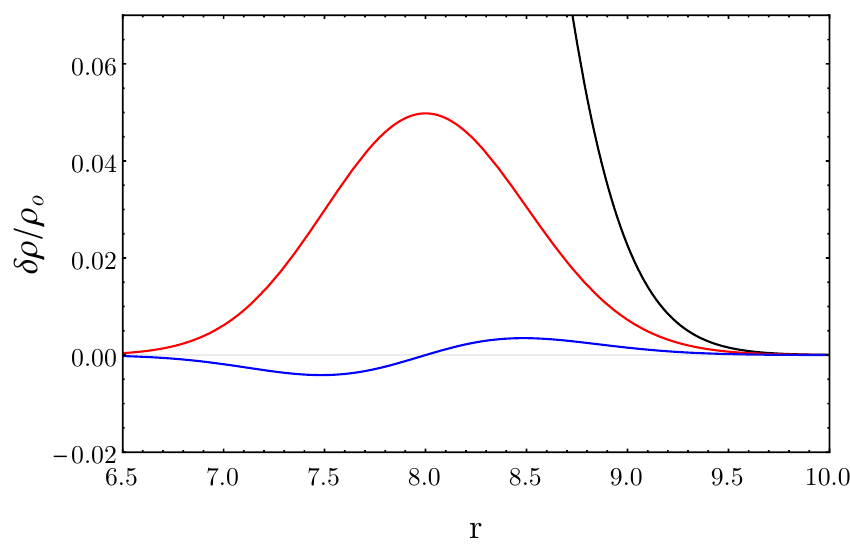
Figure 2 . Radial density profile of ν = 1 ground state near the edge (normalized to one in the bulk, black line); k = 1 particle-hole excitation (blue); Q = 1 charged edge excitation (red) (for N = 64